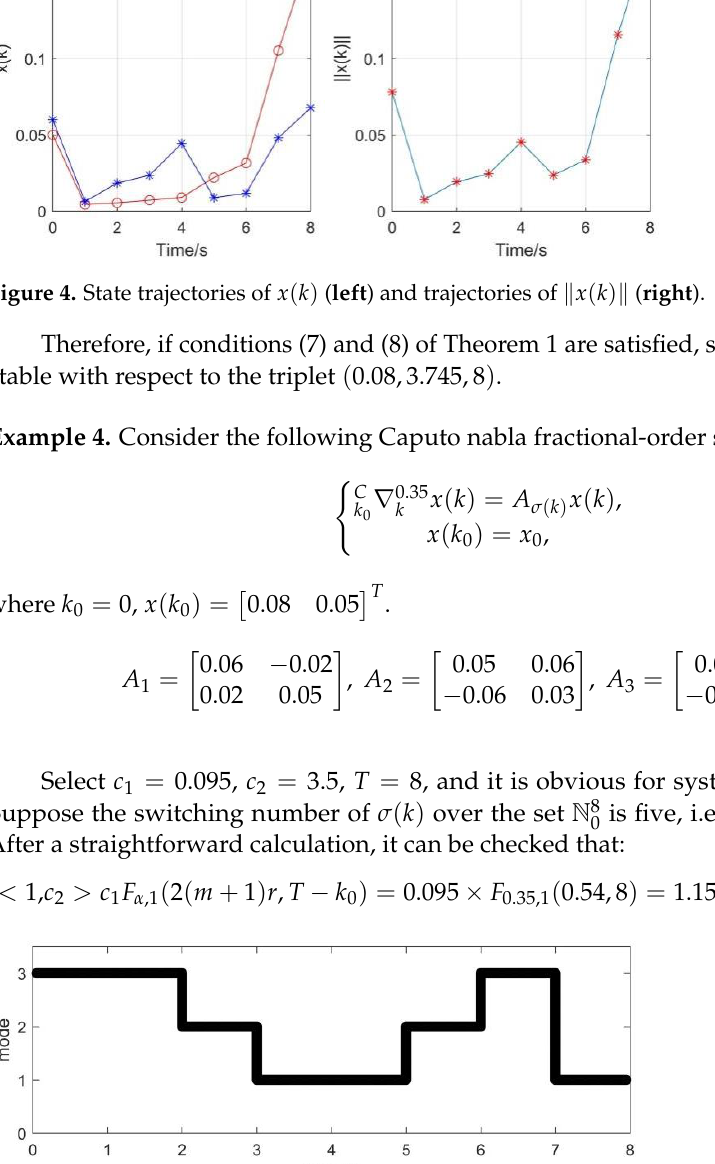
Figure 4. State trajectories of () x k ( left ) and trajectories of () x k ( right ).